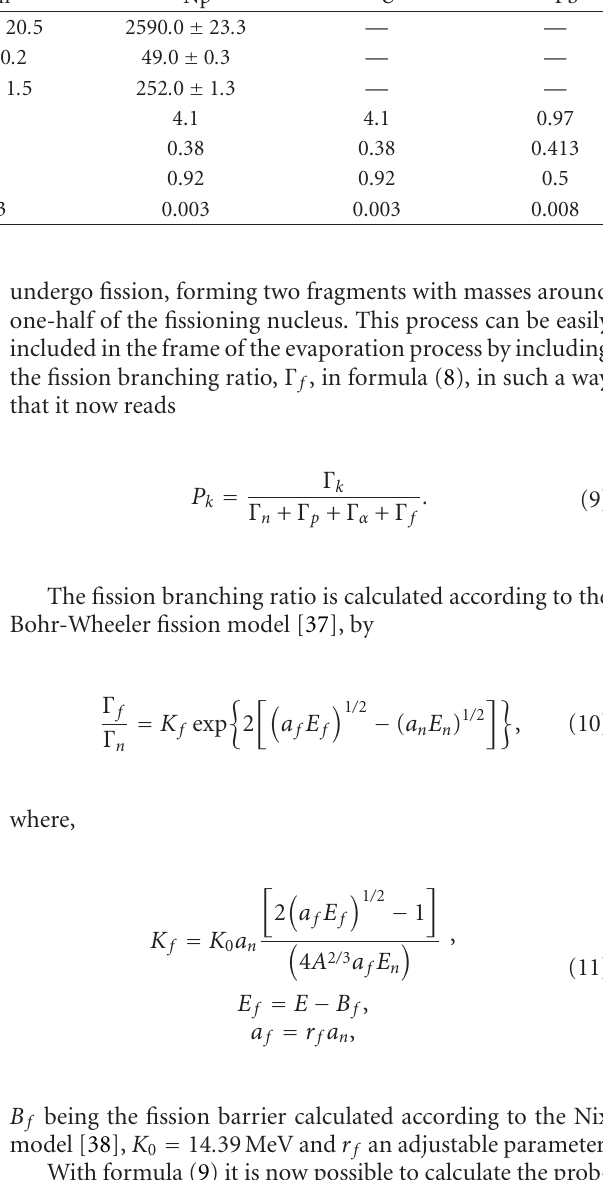
Table 3: Values for some of the relevant parameters in the multimode formula for the fission-fragment mass distributions. Parameter